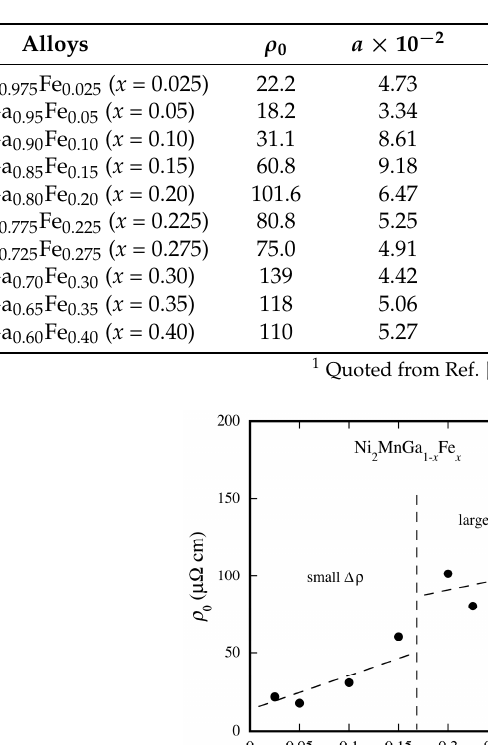
Table 1. The ρ 0 ( µ Ω cm), a ( µ Ω cm K − 1 ), b ( µ Ω cm K − 2 ) values according to the fit ρ ( T ) = ρ 0 + aT + bT 2 Table 1. The ρ 0 ( μΩ cm), a ( μΩ cm K − 1 ), b ( μΩ cm K − 2 ) values according to the fit ρ ( T ) = ρ 0 + aT + bT 2 in the temperature range below T M (i.e., in the Ferro-M (ferromagnetic martensite) phase). The range in the temperature range below T M (i.e., in the Ferro ‐ M (ferromagnetic martensite) phase). The range of validity of the fit, T M and T C are given in Table 1. of validity of the fit, T M and T C are given in Table 1.